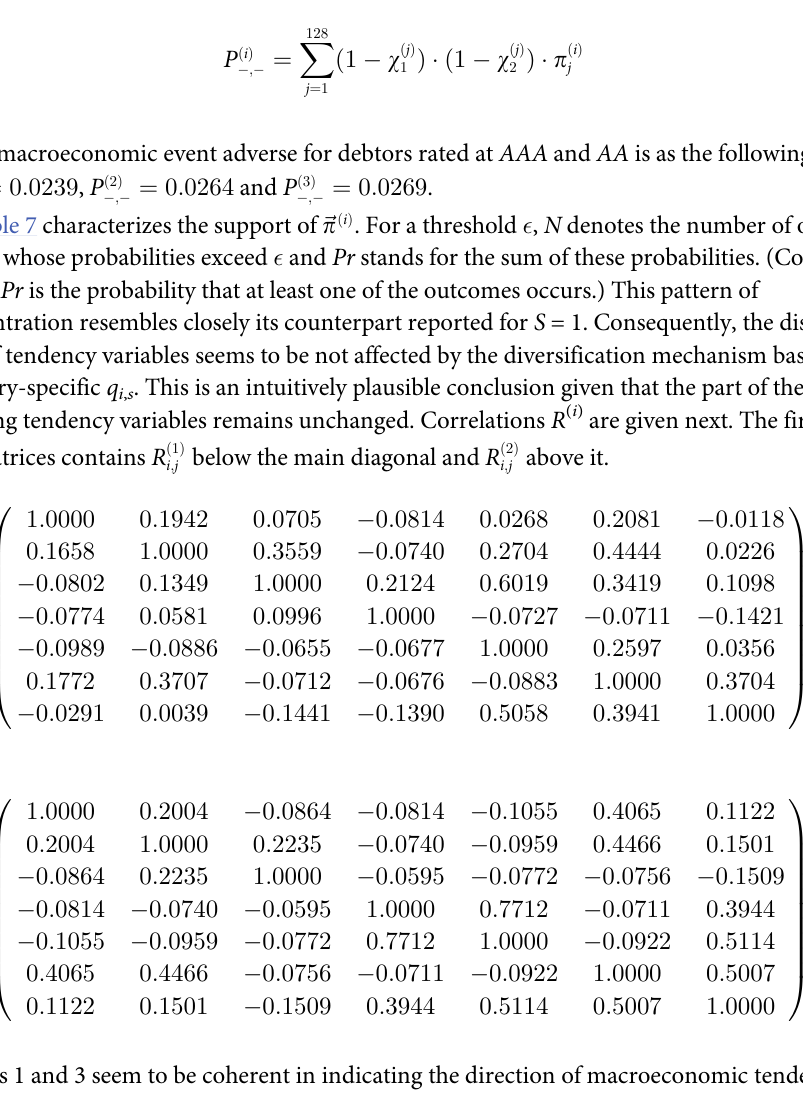
years from the period 1991–2015 were favorable for debtors rated at AAA and AA . Probability